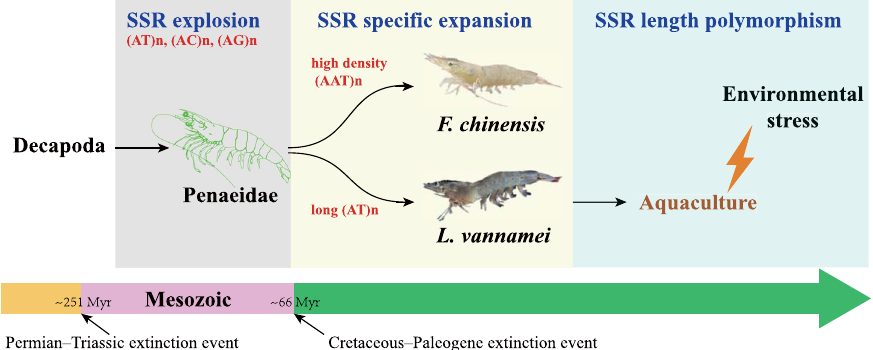
Fig. 5 SSR expansion during penaeid shrimp evolutionary history. Timescale of SSR expansion and relationships with the origination and divergence of penaeid